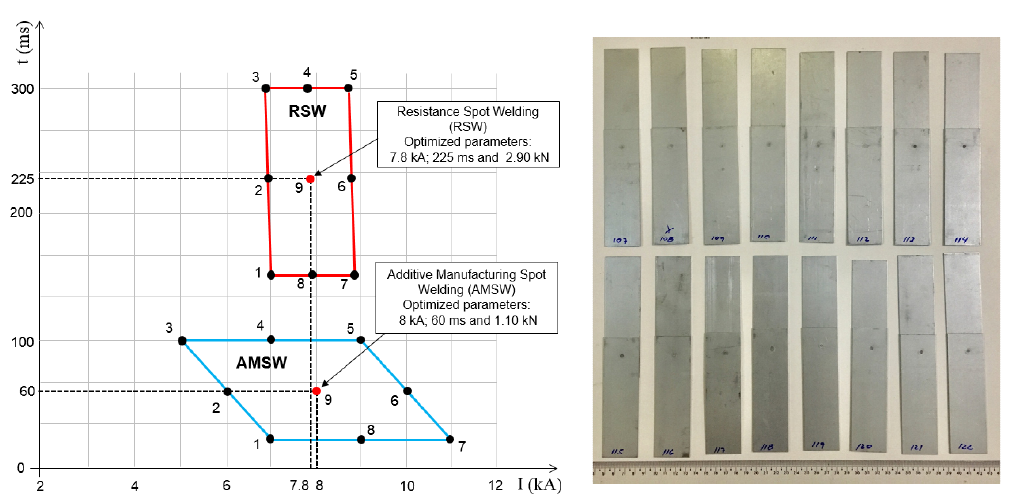
Figure 5. Weldability diagram for the determination of the optimized parameters, both for the spot welding process using additive manufacturing (AMSW) and for the resistance spot welding process (RSW), as well as examples of test specimens used in the experiments,